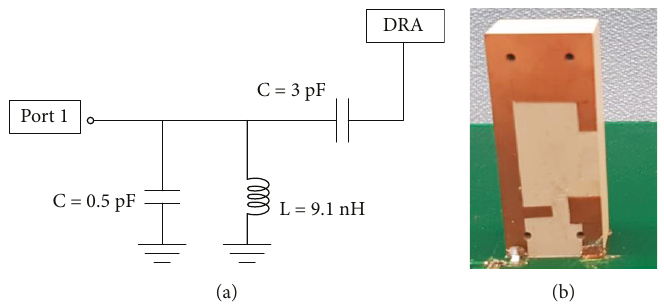
Figure 9: (a) Matching circuitry of DRA. (b) Photograph of the